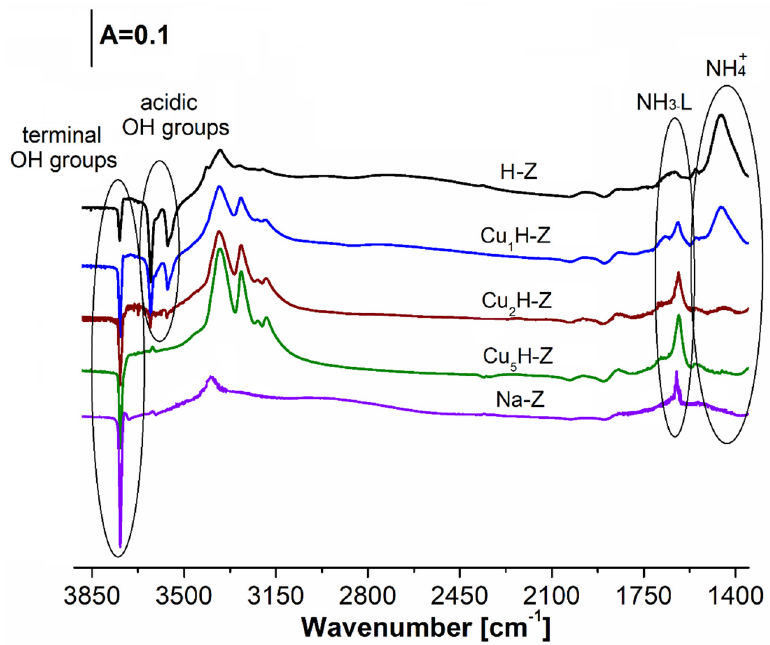
Figure 6. The co-existence of Brønsted and Lewis acid sites in dependence on the modification procedure of catalysts.